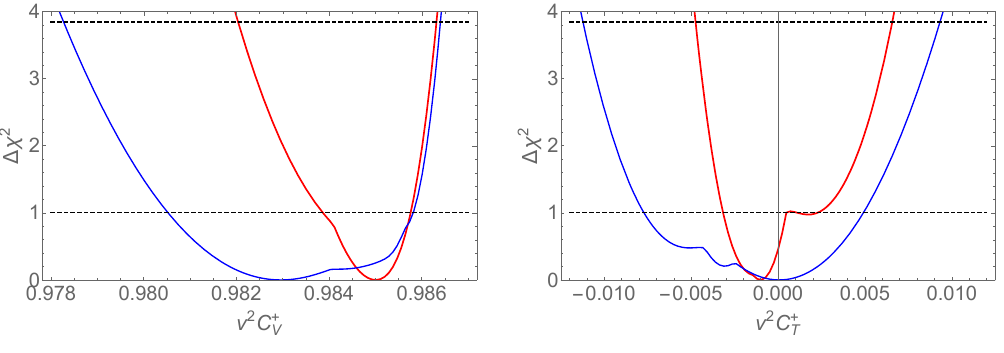
distributions for the Wilson coefficients C + min